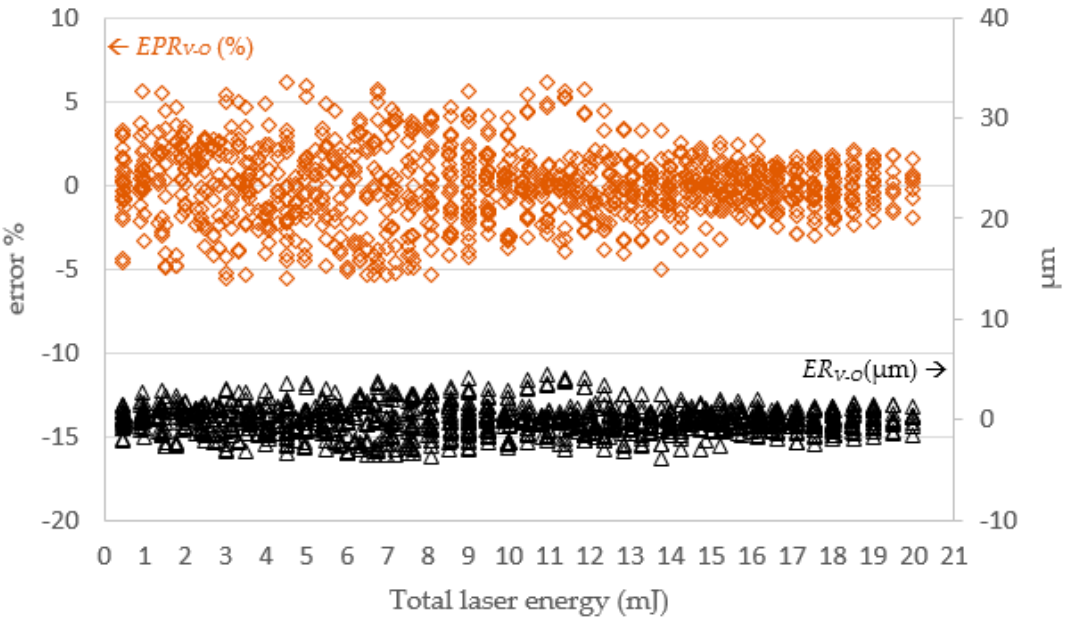
Figure 14. The SLDM-simulated diameter error versus total laser energy. Note: ER V − O = R V − R O ; EPR V − O = ( R V − R O )/R O (%) .